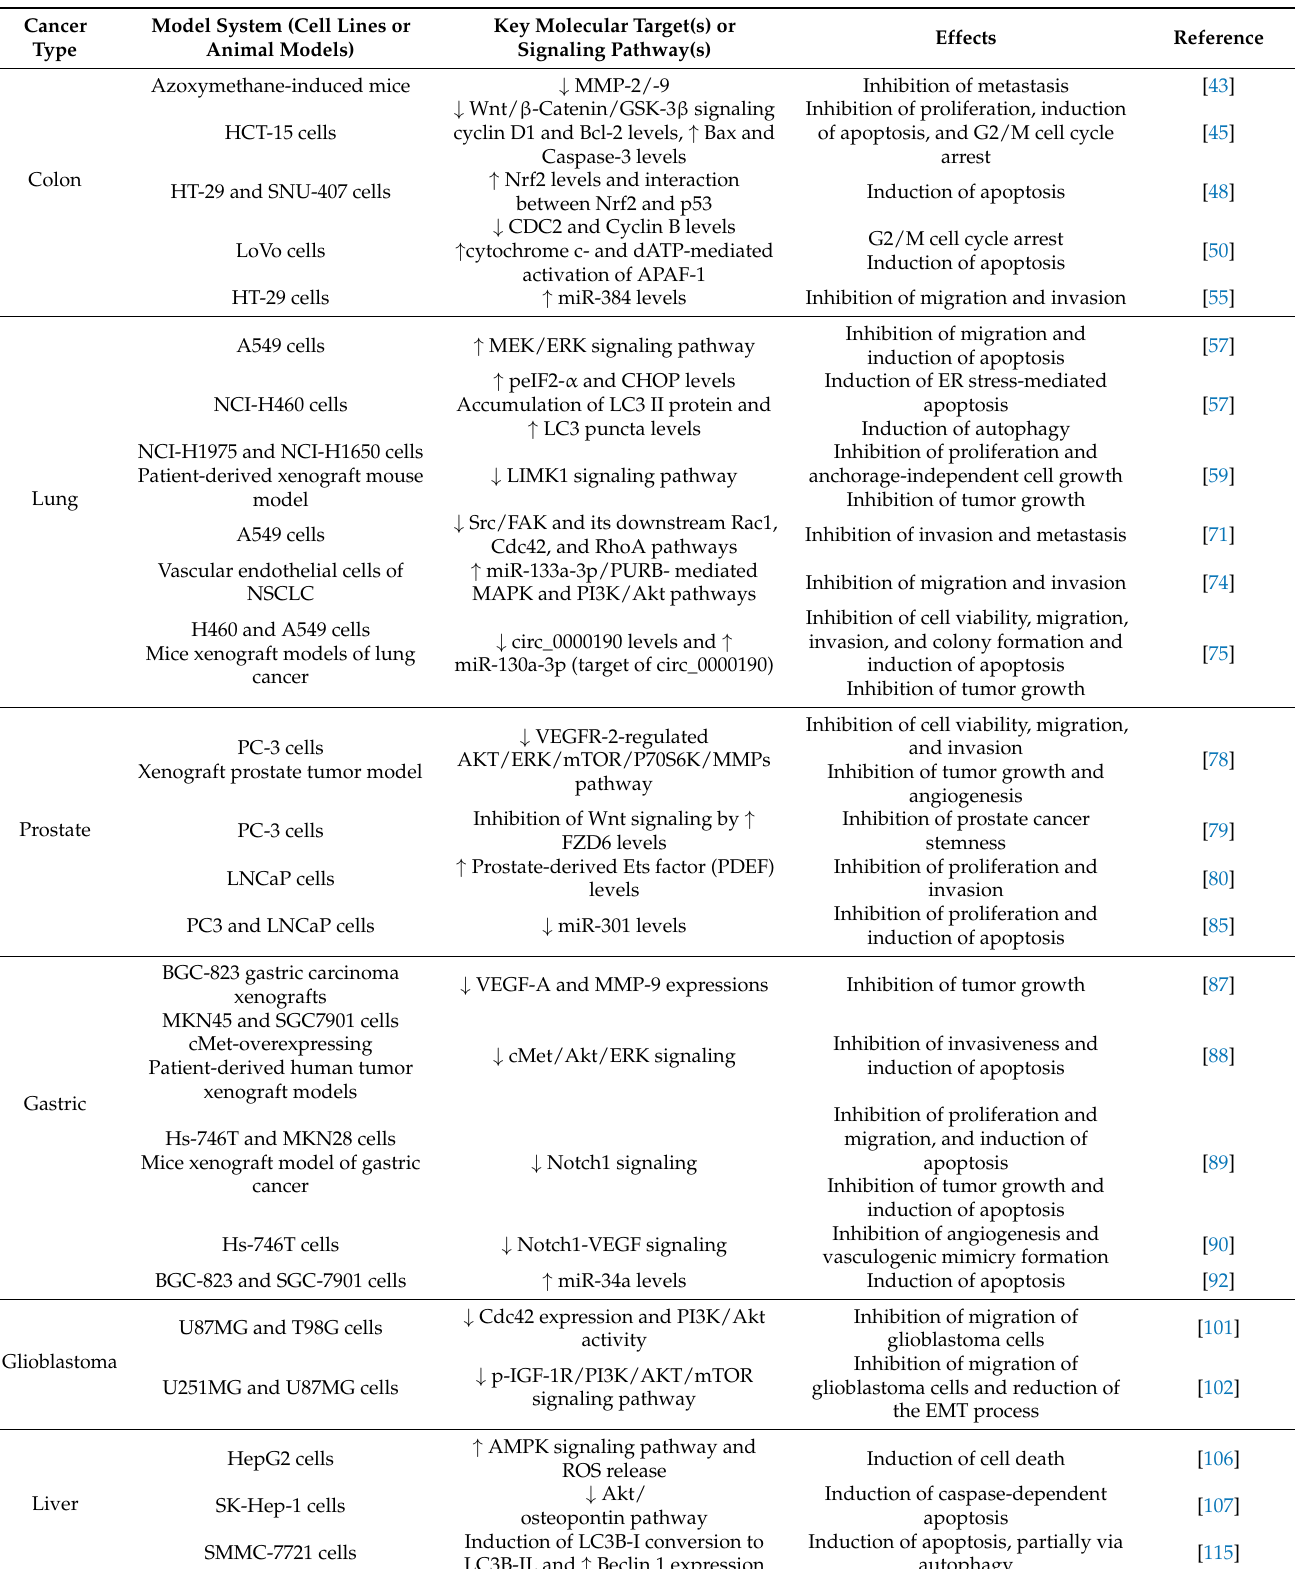
Table 1. Summary of key findings regarding the anticancer properties of Luteolin in different cancer types. Arrows represent ( ↑ ) upregulation and ( ↓ ) downregulation of